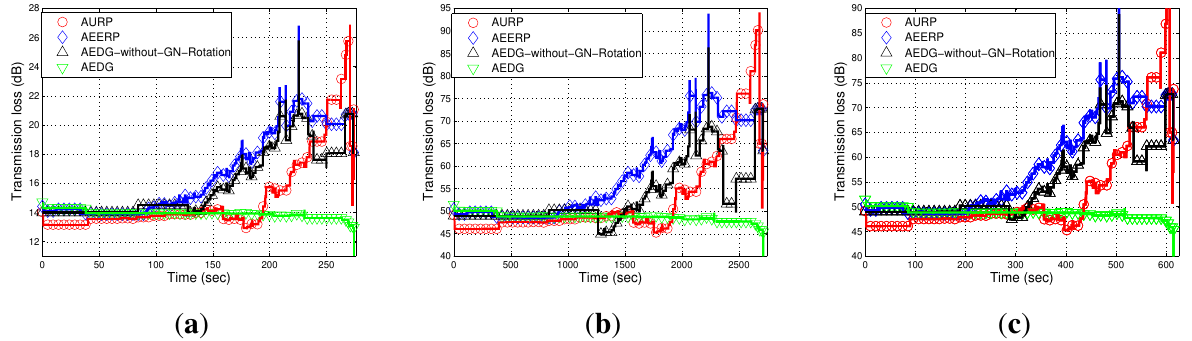
Figure 15. Transmission loss. ( a ) 10 nodes deployed in 100 m × 100 m; ( b ) 100 nodes deployed in 100 m × 100 m; ( c ) 100 nodes deployed in 10 km × 10